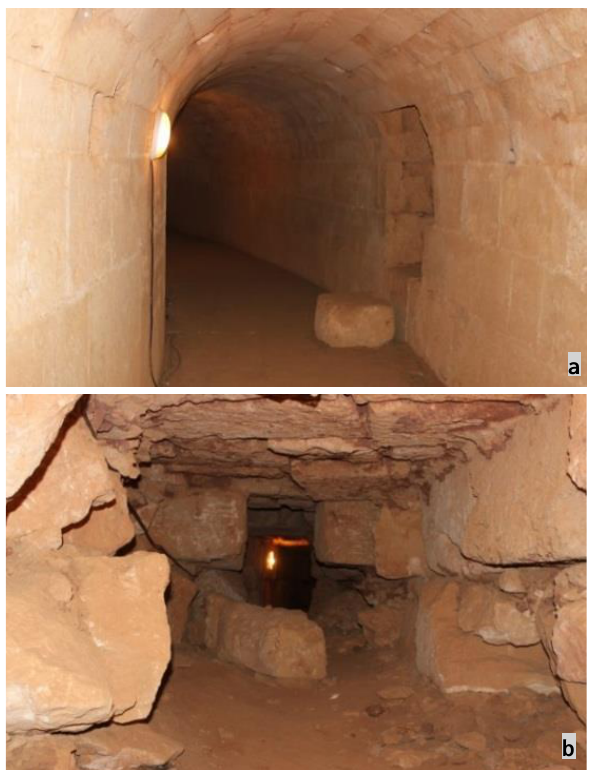
Figure 5. Views of the interior of the Mausoleum, a. the circular gallery, b. the funeral chambers without any contents ©